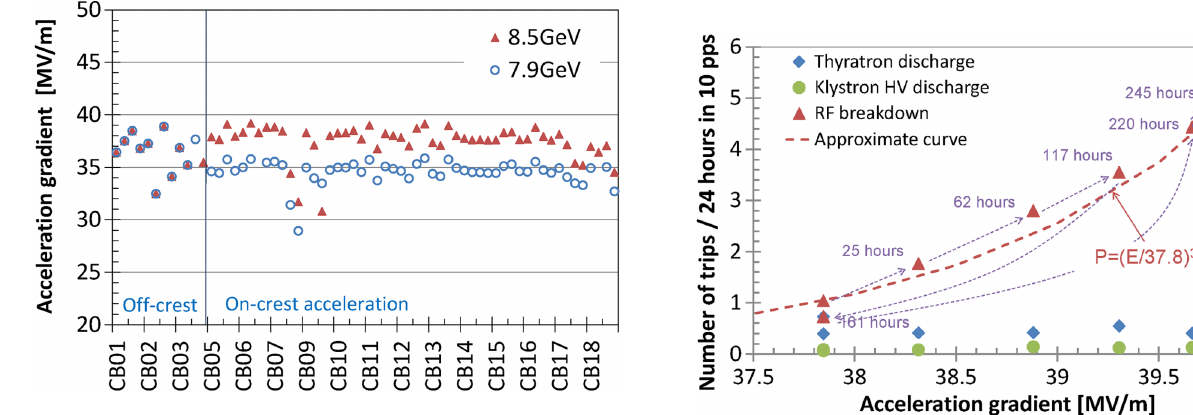
FIG. 17. Average trip rate of the C -band accelerator units as a function of gradient. The number of hours operated during each measurement are also